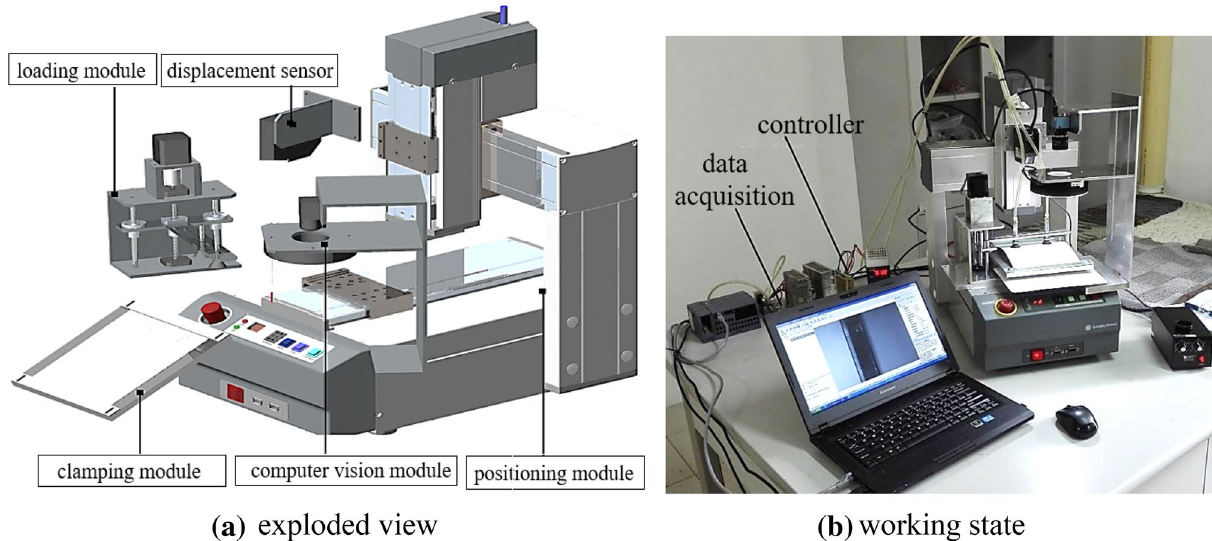
Fig. 10 Experimental